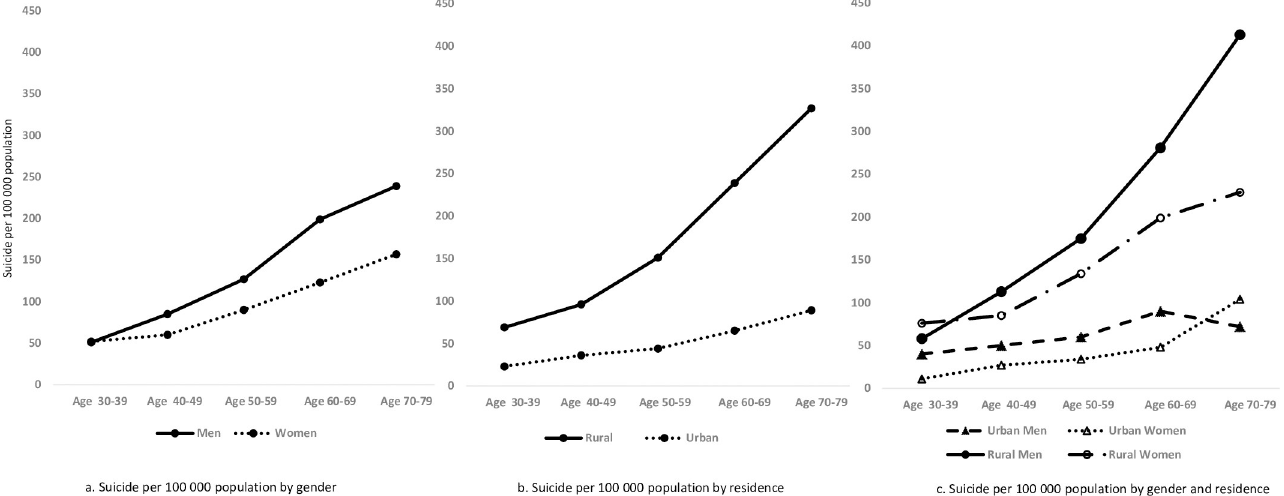
Fig 1. Mortality rates of suicide by gender, residence, and age group. Fig 1a. Suicide per 100,000 population by gender; Fig 1b. Suicide per 100,000 population by residence; Fig 1c. Suicide per 100,000 population by gender and residence.